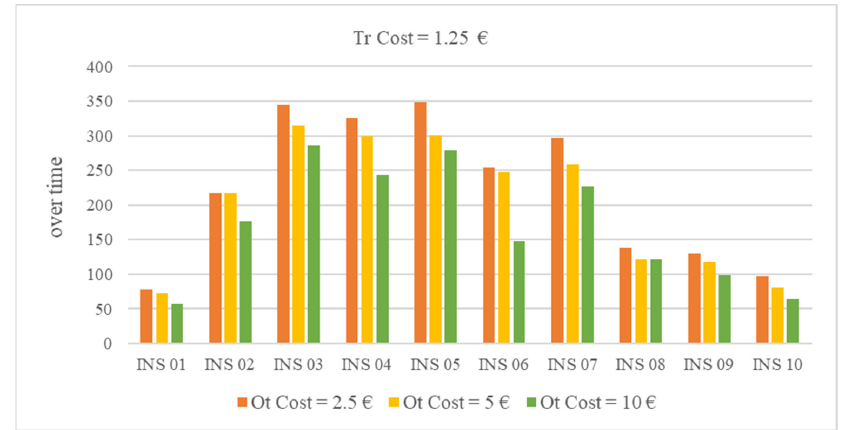
Figure 8. The amount of imposed “Overtime” with respect to various overtime penalties.